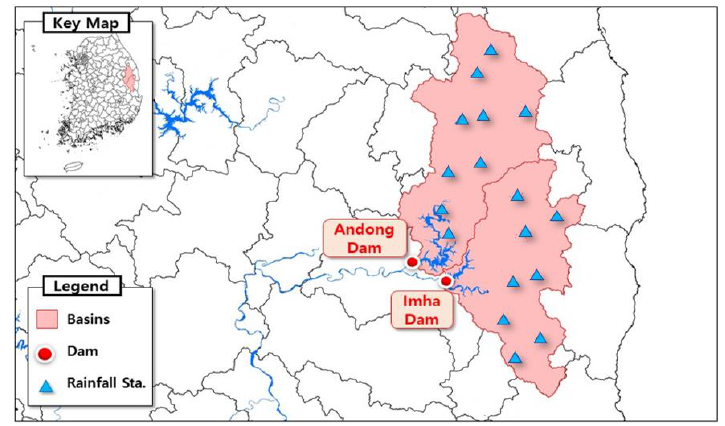
Figure 3. Location and Watershed of Andong and Imha Dams.